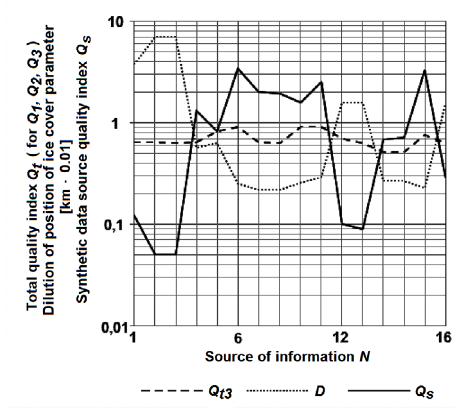
Fig. 4. Complex indicators Q t3 , D and Q s of data